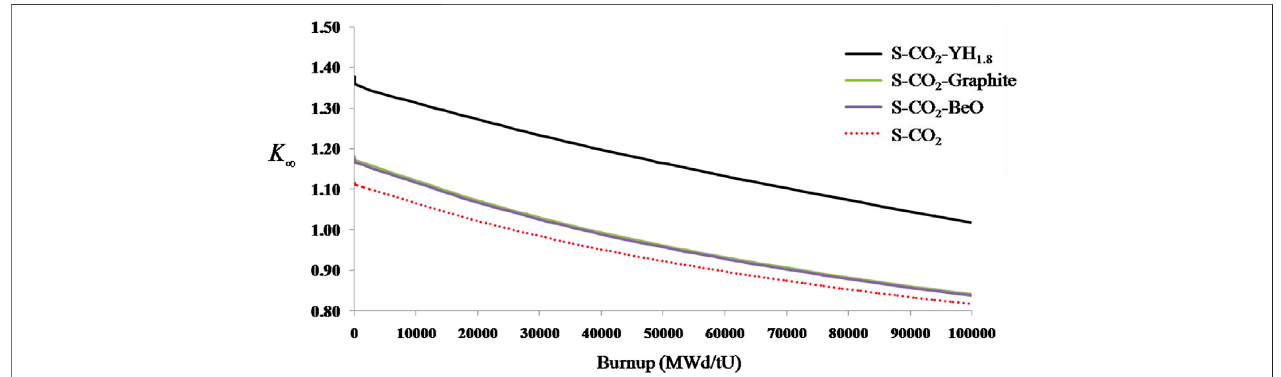
FIGURE 8 | K ∞ by different moderating materials versus burn